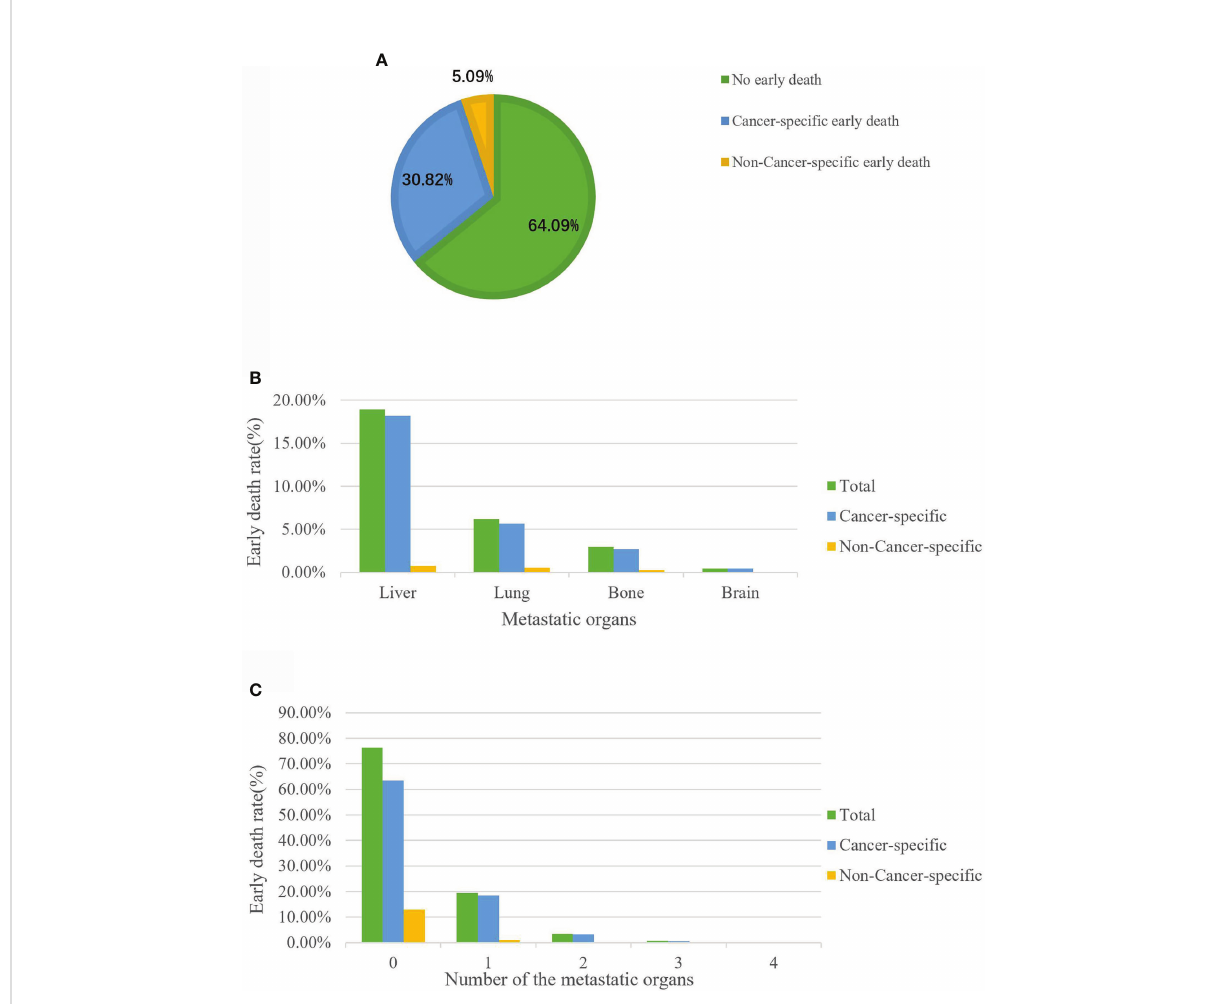
FIGURE 2 The incidence of cancer-speci fi c early death among elderly GC patients (A) . Distribution of early death among elderly GC patients strati fi ed by metastatic site (B) and the number of metastatic organs (C)